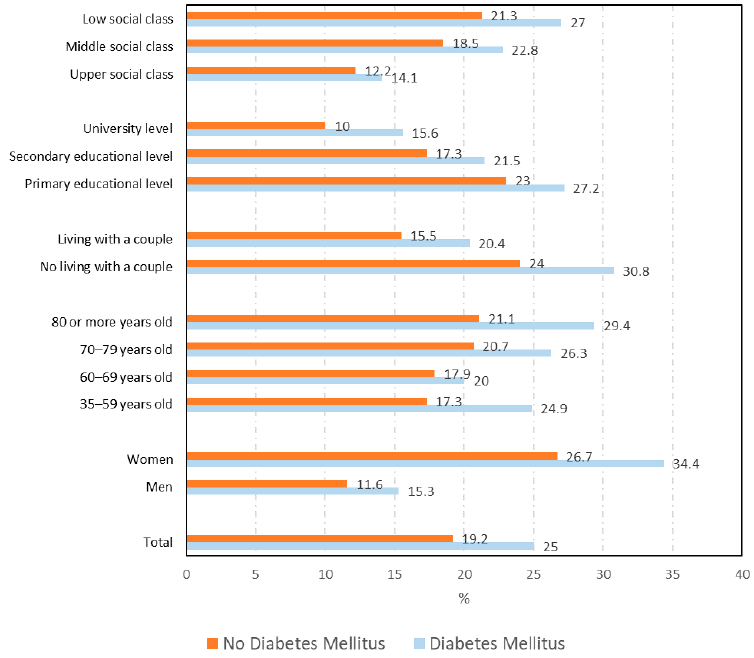
Figure 1. Prevalence of mental disorders according to sociodemographic variables among diabetes mellitus cases and controls.